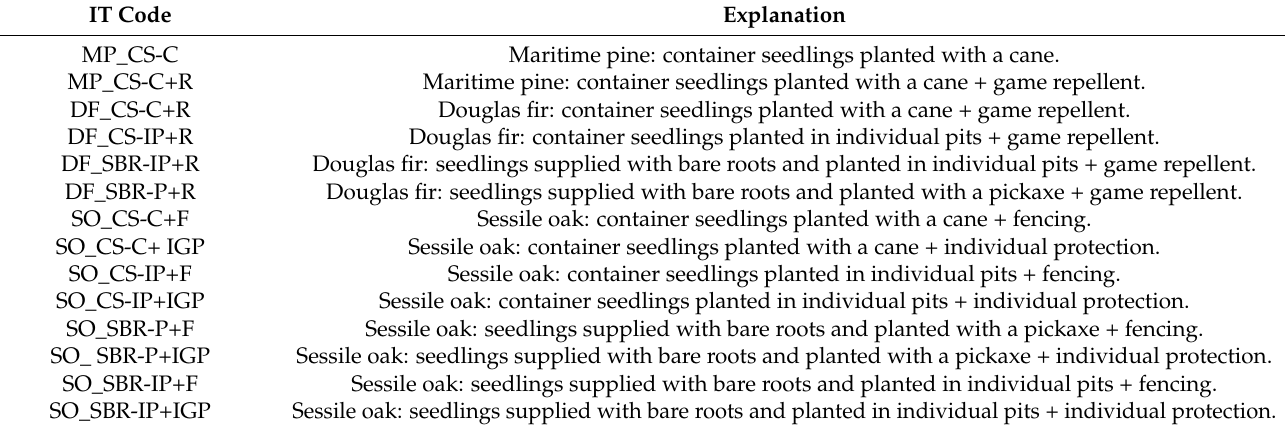
Table 1. Itineraries of plantations with their corresponding code and their detailed meaning. The itinerary code (IT code) corresponds to the species (maritime pine ( Pinus pinaster Ait.), Douglas fir ( Pseudotsuga menziessi Mirb.), and sessile oak ( Quercus petraea Liebl.)), followed by the type of planting and the type of game